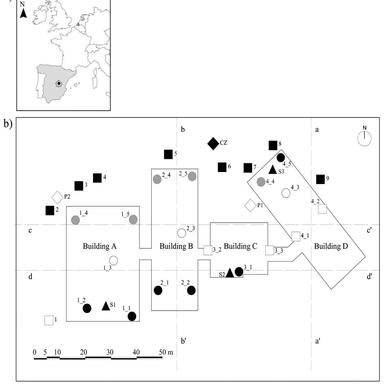
(a) Geographical location of Cuenca. (b) Plan view of the Institute of Technology. Lines: vertical profiles used in Fig. 1. Symbols: Black circles, subgroup PG1S of water content profiles; white circles, subgroup PG1C; grey circles, subgroup PG1N; white squares, PG2 profiles; black squares, PG3 profiles; triangles, boreholes constructed prior to the construction of the buildings; black diamond, calibration zone; white diamonds: piezometers.